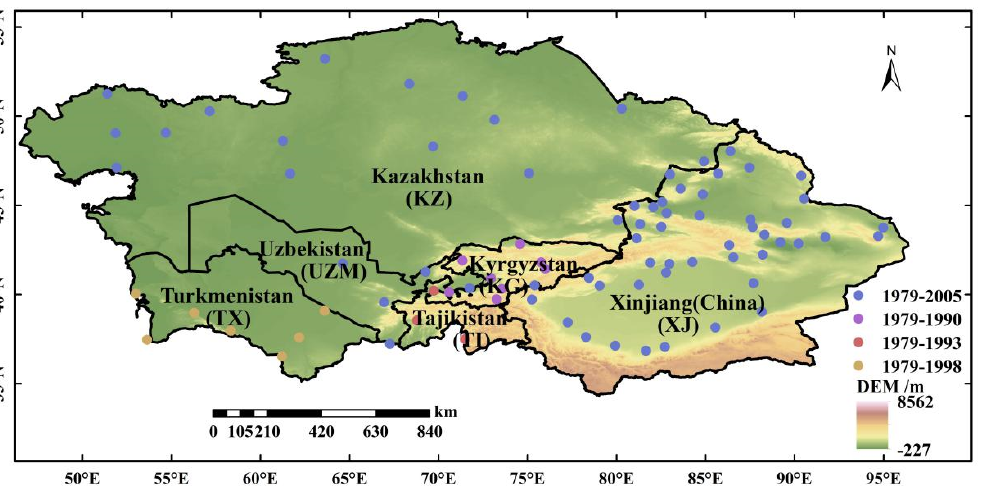
Figure 1. The topographic map and geographical distribution of chosen stations in CA. The dots indicate locations of meteorological stations and each color represents groups with different lengths of available daily precipitation records used in the present study.